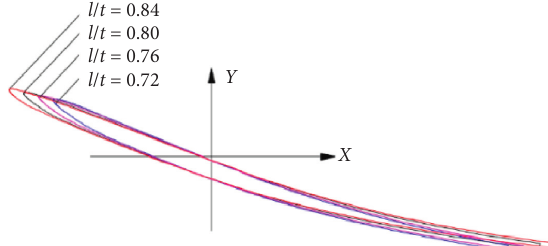
Figure 4: Schematic diagram of the density of the cascade at the blade